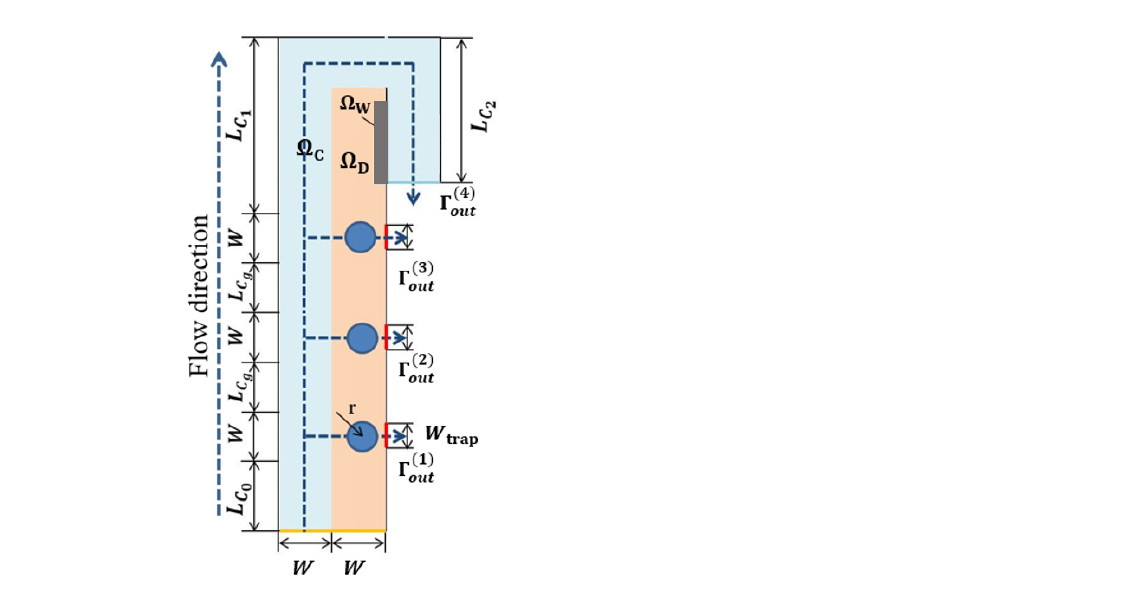
9 of 17 Figure 8. Cell capture array with capture direction perpendicular to flow direction (1 × 10). 3.2. Multi-Cell Capture Model